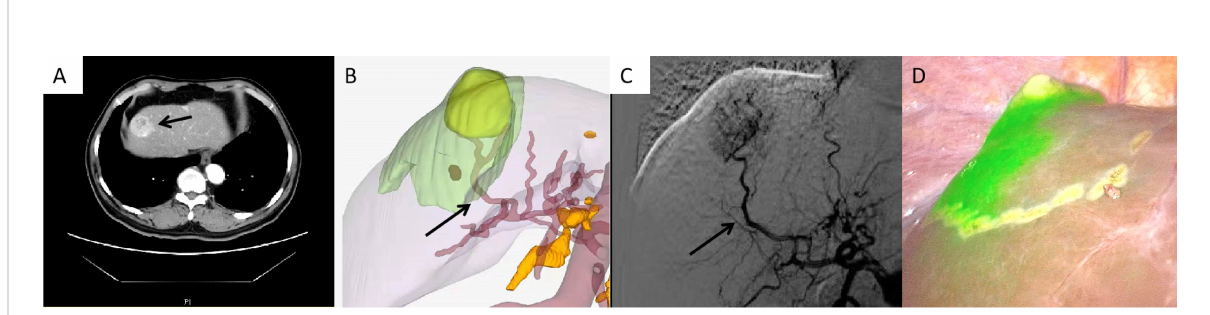
FIGURE 3 Case 1 (patent with HCC in S8v). (A) CT scan of HCC in S8v. (B) 3D modeling of the HCC and its watershed region. (C) Selected hepatic artery under DSA examination. (D) Positive ICG staining of